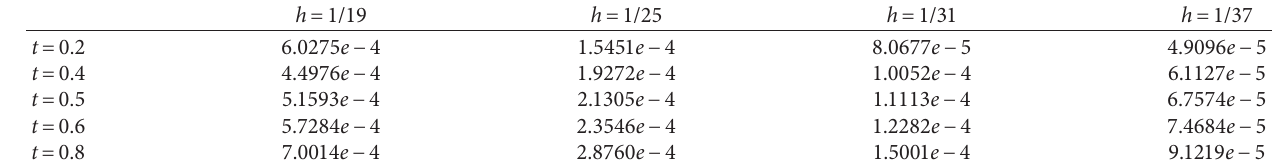
Table 7: The maximum errors of Algorithm 2 to Example 2 for τ � 0.0004.